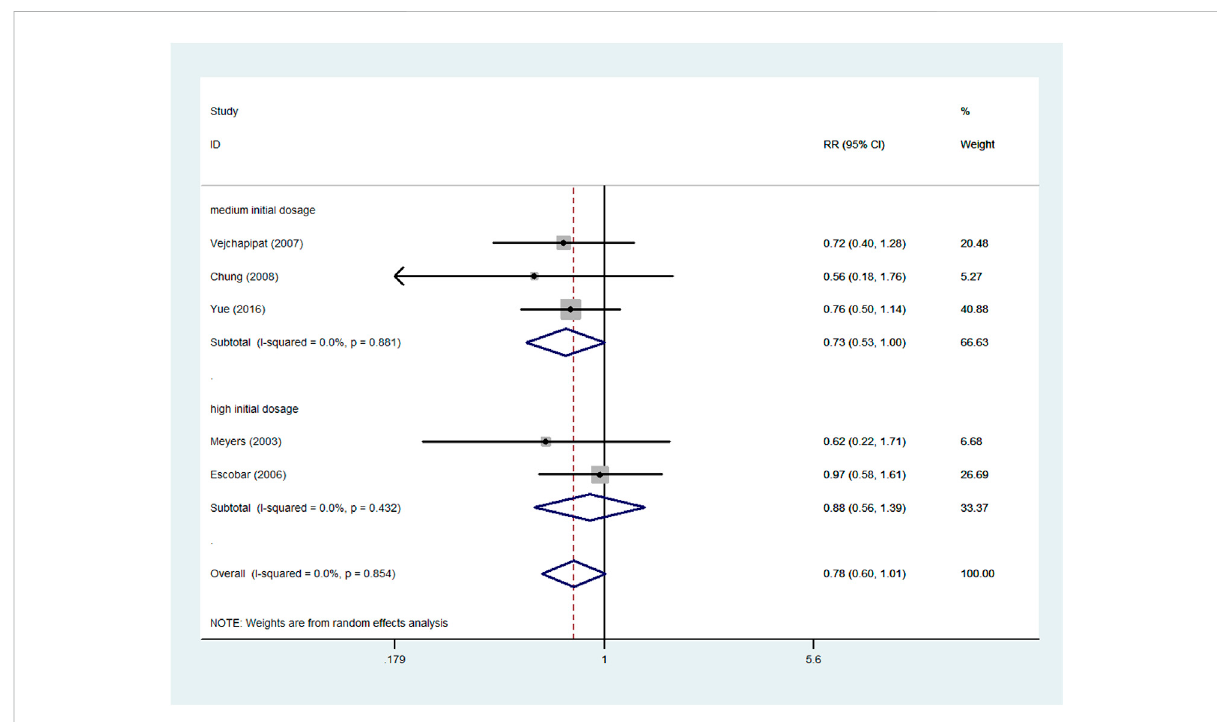
FIGURE 7 Forest plot for postoperative cholangitis rate of steroid vs. non-steroid group, and the subgroup analysis for initial dosage.